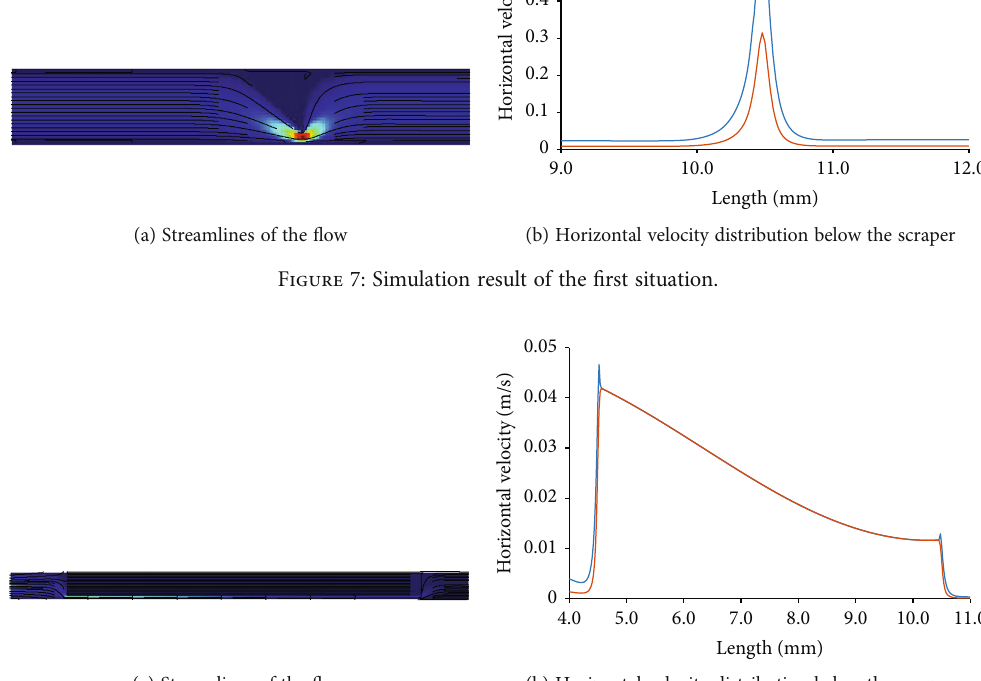
Figure 8: Simulation result of the second